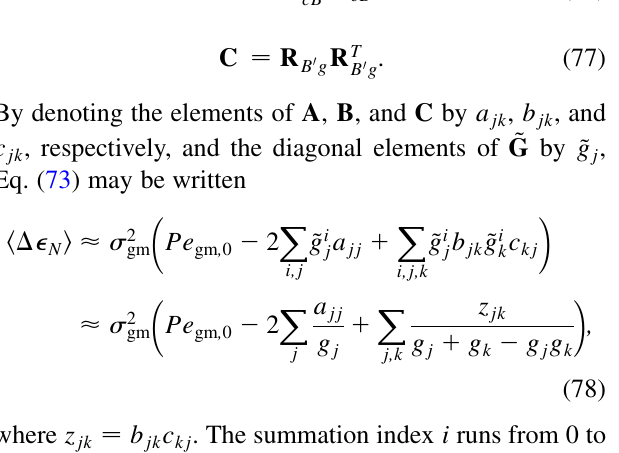
FIG. 16. (Color) Theoretical standard deviation of BPM pattern components for different imperfections after one pulse. While ground motion causes a lasting deviation, the other imperfec- tions cause deviations that are uncorrelated from one pulse to another. They have therefore been reduced by a factor 10 to reflect the effect of a gain g (cid:2) 0 : 1 . Note the similarity between the results for ground motion and quadrupole jitter. This is a consequence of the fact that ground motion effects are mainly caused by displaced